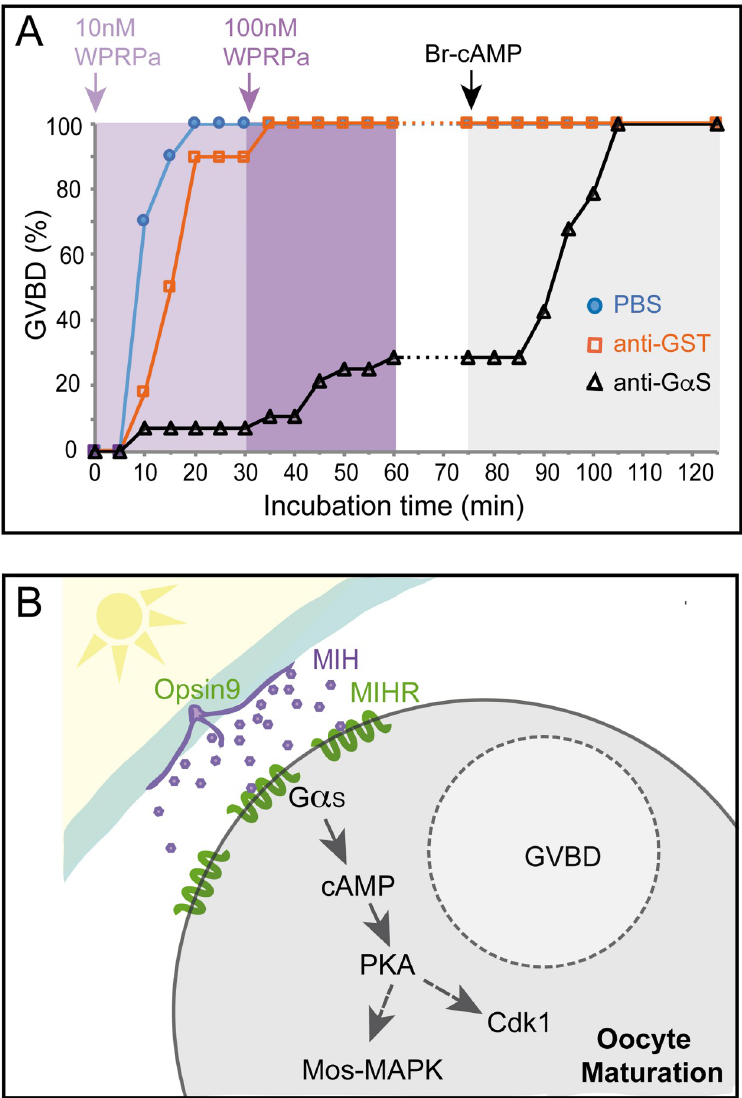
Fig 5. Involvement of G α s in Clytia oocyte maturation. (A) Results of an antibody inhibition experiment. Maturation response (scored as percent GVBD over time) of isolated oocytes injected with antibodies or buffer, then challenged first with a low dose of MIH (10 nM WPRPamide), then with a higher dose (100 nM WPRPamide), and finally with Br-cAMP to verify maturation competence, as indicated by the colored arrows and background shading. Oocytes injected with PBS (blue circles) or a control anti-GST antibody (orange squares) responded efficiently to MIH, whereas very few oocytes injected with anti-G α s (black triangles) underwent GVBD after treatment with the low dose of MIH and only 29% following the high dose. The number of oocytes per group in this experiment was 30, 28, and 30, respectively. All of them had undergone GVBD by the end of the experiment. Times from the start of the first incubation are shown on the x-axis. Full datasets from five independent experiments are available in S4 Data. (B) Scheme illustrating the proposed cascade initiating Clytia oocyte maturation initiation. Following light stimulation after a dark period, Opsin9 mediates release of MIH neuropeptides from specialized cells (purple) of the gonad ectoderm (cyan). Activation of the MIHR (green) at the oocyte surface releases G α S to promote an increase in cytoplasmic cAMP, activating PKA. Unknown PKA substrates likely trigger in parallel Cdk1 activation and thus GVBD, and Mos1 synthesis to initiate the MAPK cascade.; Br-cAMP, bromoadenosine 3 0 ,5 0 -cyclic monophosphate; GST, Glutathione-S-Transferase; GVBD, germinal vesicle breakdown; MIH, maturation-inducing hormone; MIHR, MIH receptor; PKA, protein kinase A.